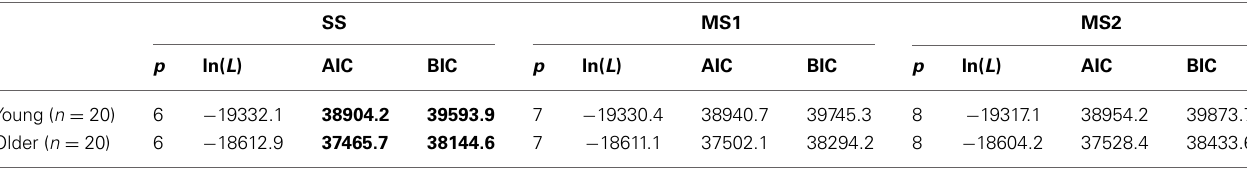
Table 3 | Goodness of fit of the models.